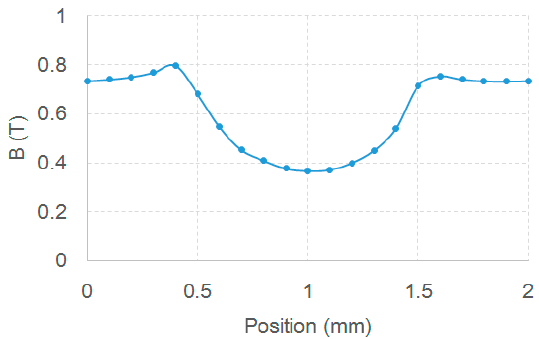
Figure 11. The B values of the air gap with respect to displacement.